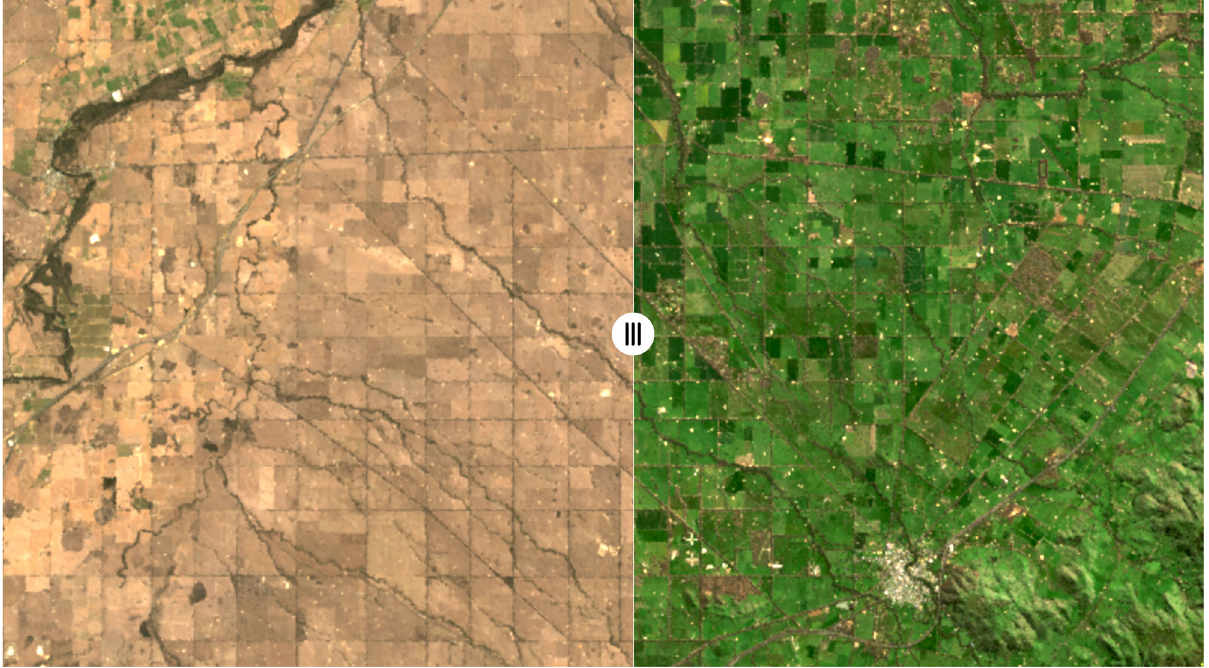
Fig. 7 Comparison between the Barest Earth output and a single vegetated observation over an agricultural district in south-eastern Australia. Split screen view from National Map (http://nationalmap.gov.au/) showing the difference between our Barest Earth product (left) and (right) a single clear Landsat-8 observation (31/08/2019) in true colour. Location is 46.53550°S